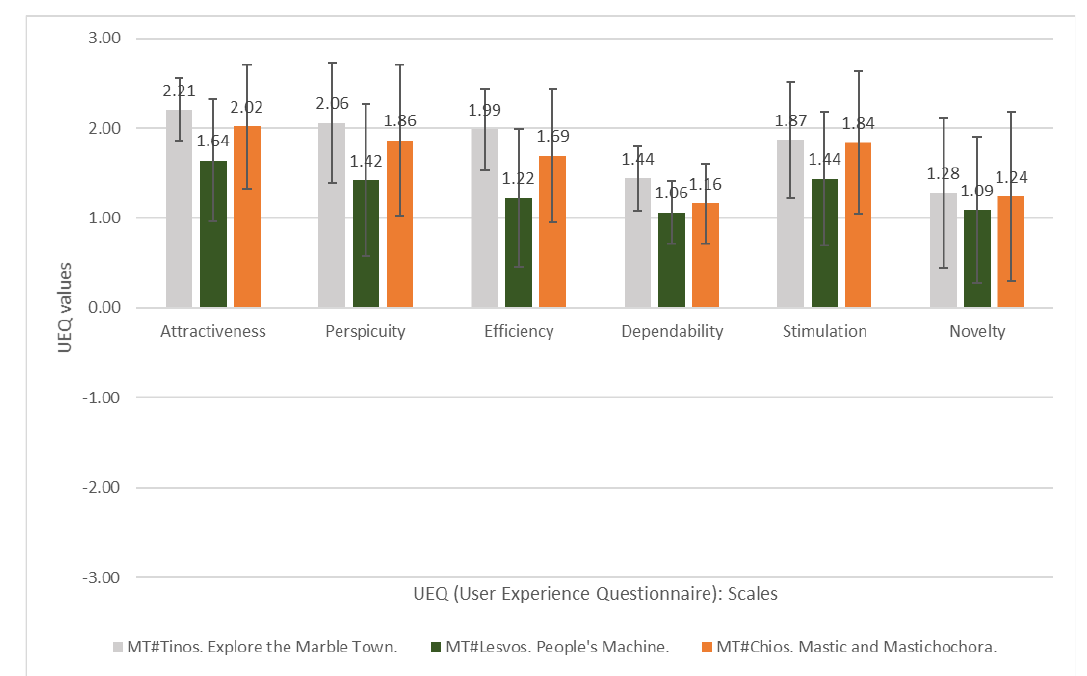
Figure 10. User Experience Questionnaire: responses from field study participants. Table 6. Summary of data from user analytics (August–November 2021).